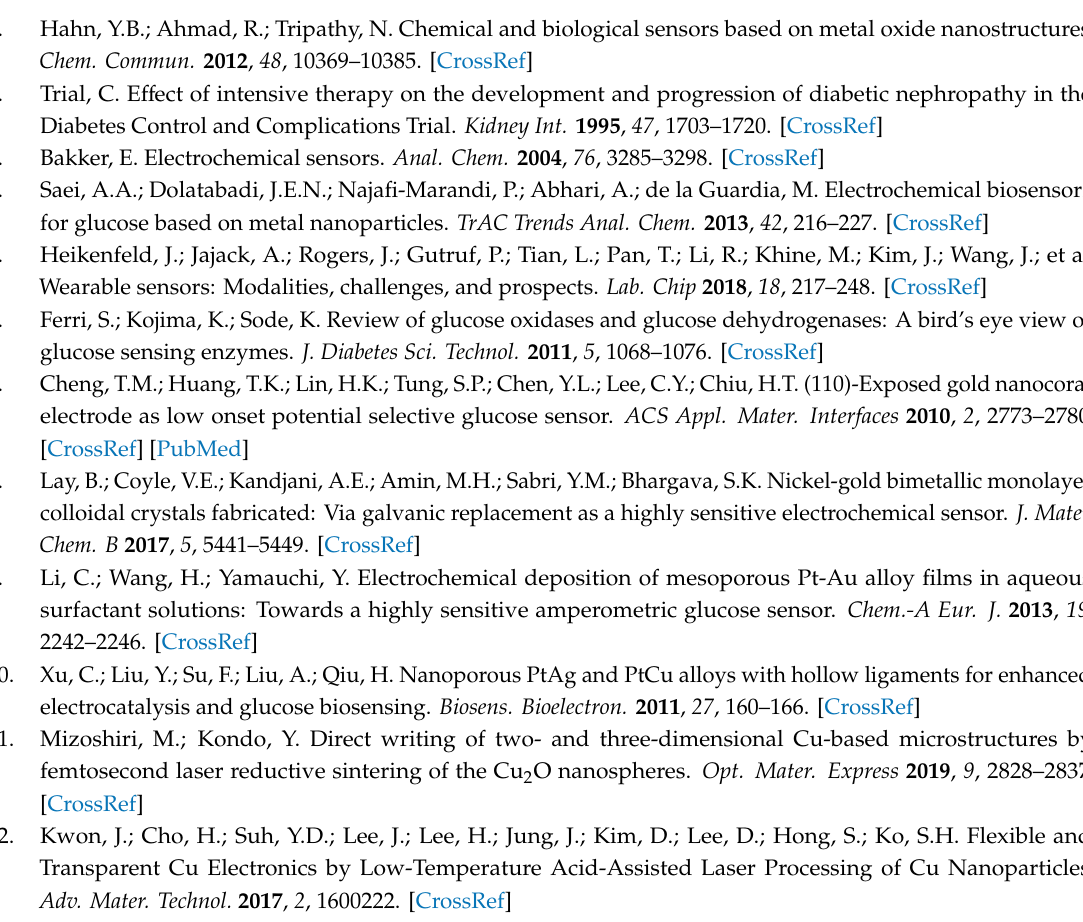
Figure S1: The experimental setup used for laser-induced deposition of iridium-containing microstructures: 1—cw 532 nm diode-pumped solid-state Nd:YAG laser, 2—mirrors, 3—splitting cube, 4—objective lens, 5—the experimental cell, 6—neutral density flter, 7—web camera, 8—personal computer, 9—the computer controlled motorized stage, Figure S2: EDX spectrum of iridium (I r ) microstructures, Figure S3: EDX spectrum of iridium-platinum (Ir-Pt) microstructures, Figure S4: EDX spectrum of iridium-gold (Ir-Au) microstructures; Figure S5: XRD pattern of iridium (Ir) microstructures, Figure S6: XRD pattern of iridium-platinum (Ir-Pt) microstructures, Figure S7: XRD pattern of iridium-gold (Ir-Au)